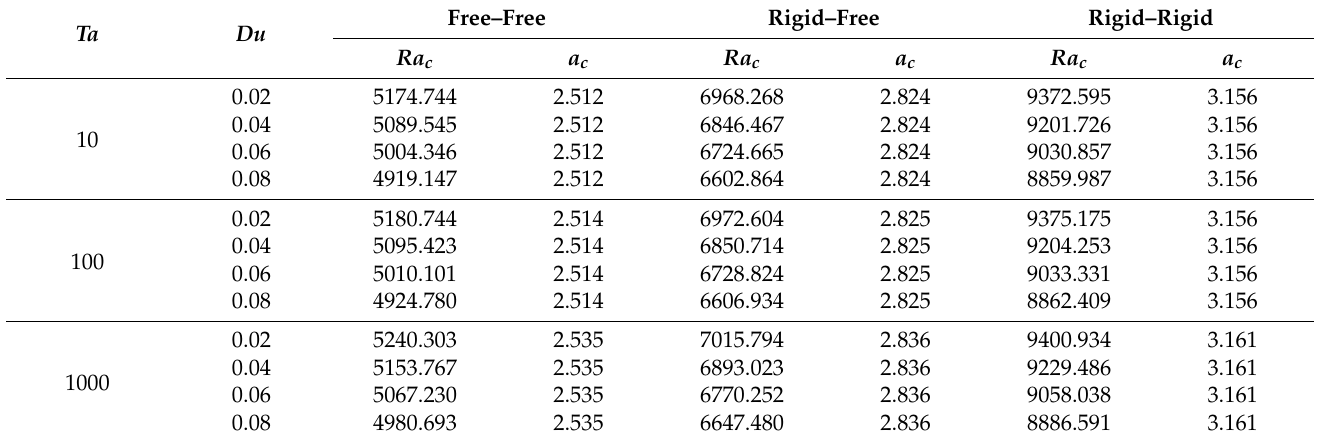
Table 4. Critical values of Ra and a for Da = 0.01, Sr = 0.2, Rs = 200, Le = 5, Λ = 8, M = 0.9 , φ =